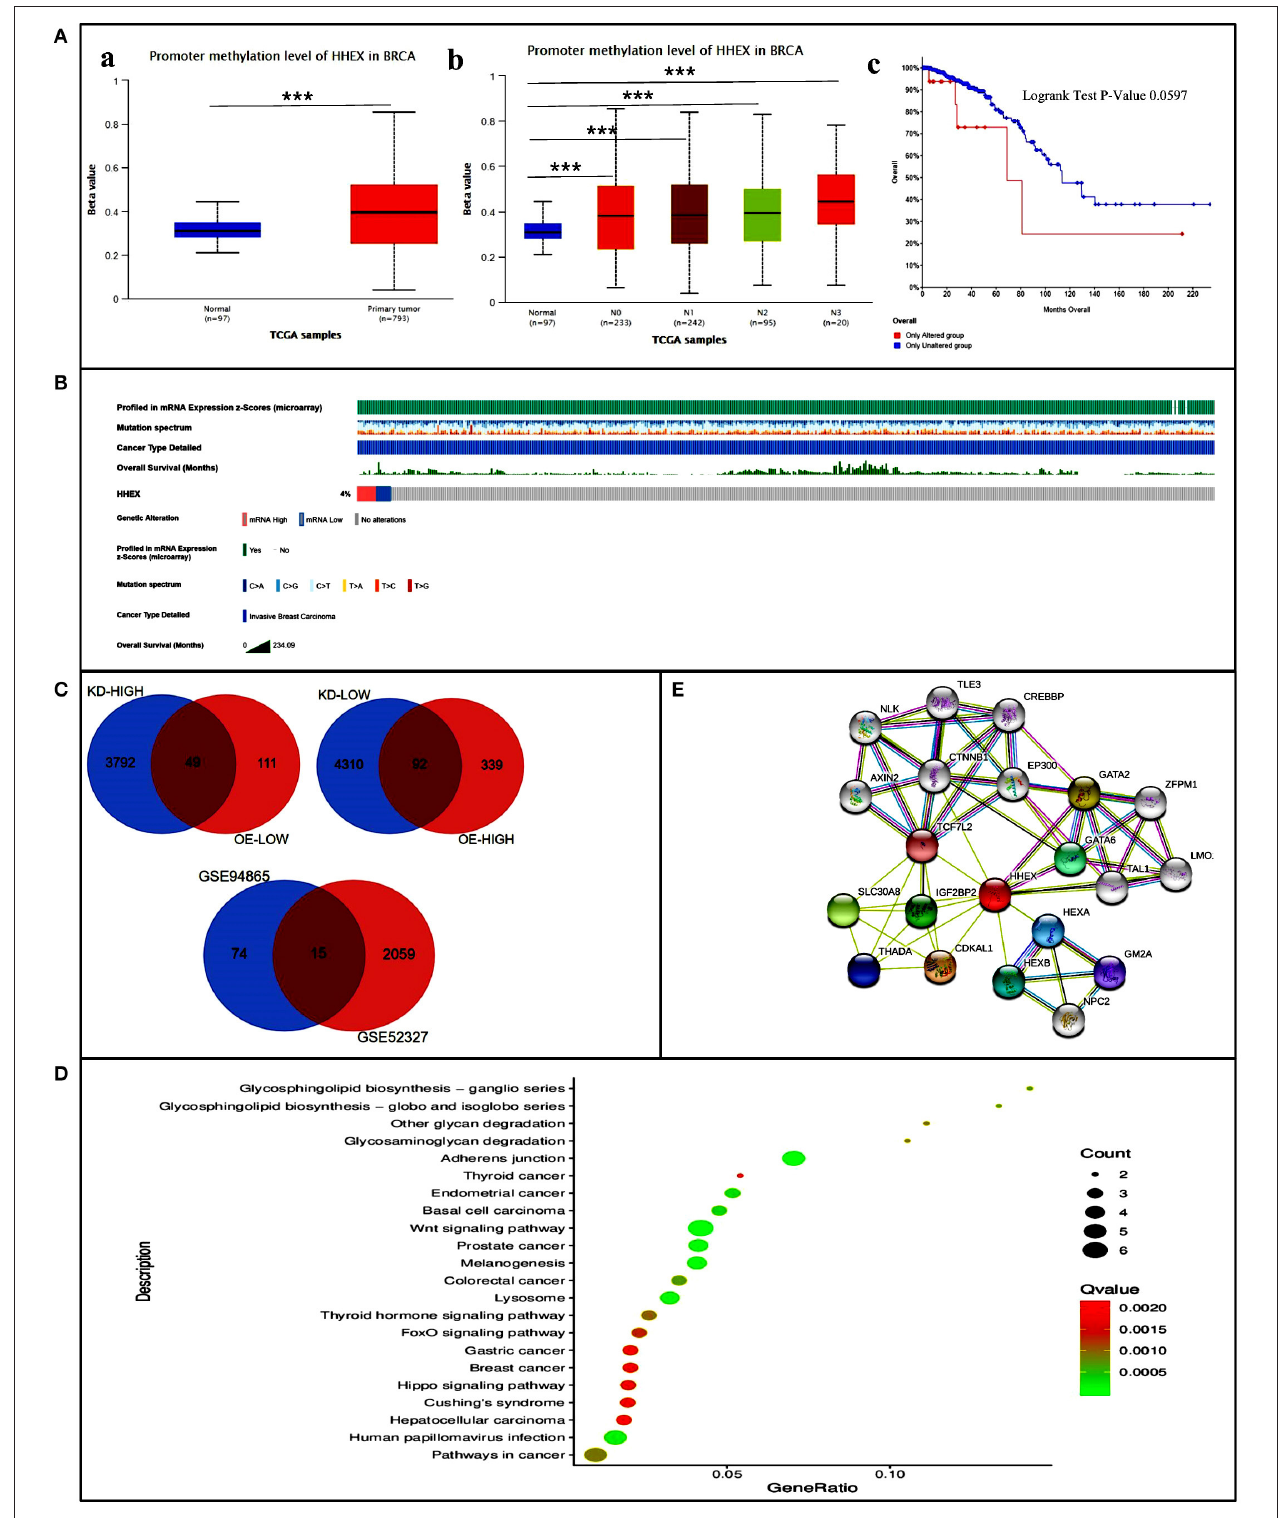
FIGURE 4 | Promoter methylation and genetic alterations of HHEX and potential regulatory mechanism of HHEX in regulating breast cancer (BC). (A) Promoter methylation and genetic alterations of HHEX in BC patients. (a) Promoter methylation levels of HHEX in BC determined using UALCAN. (b) Relationship between nodal metastasis status of BC with the promoter methylation of HHEX determined using UALCAN. (c) OS for HHEX alterations was analyzed using cBioportal. (B) Genetic alterations of HHEX in BC patients determined using cBioportal. (C) Venn of the DEGs related to BC stem cells and the DEGs after HHEX changed. (D) KEGG pathway enrichment of the 15 common genes. (E) The neighbor gene network of 15 genes was constructed using STRING. *** P < 0.001.